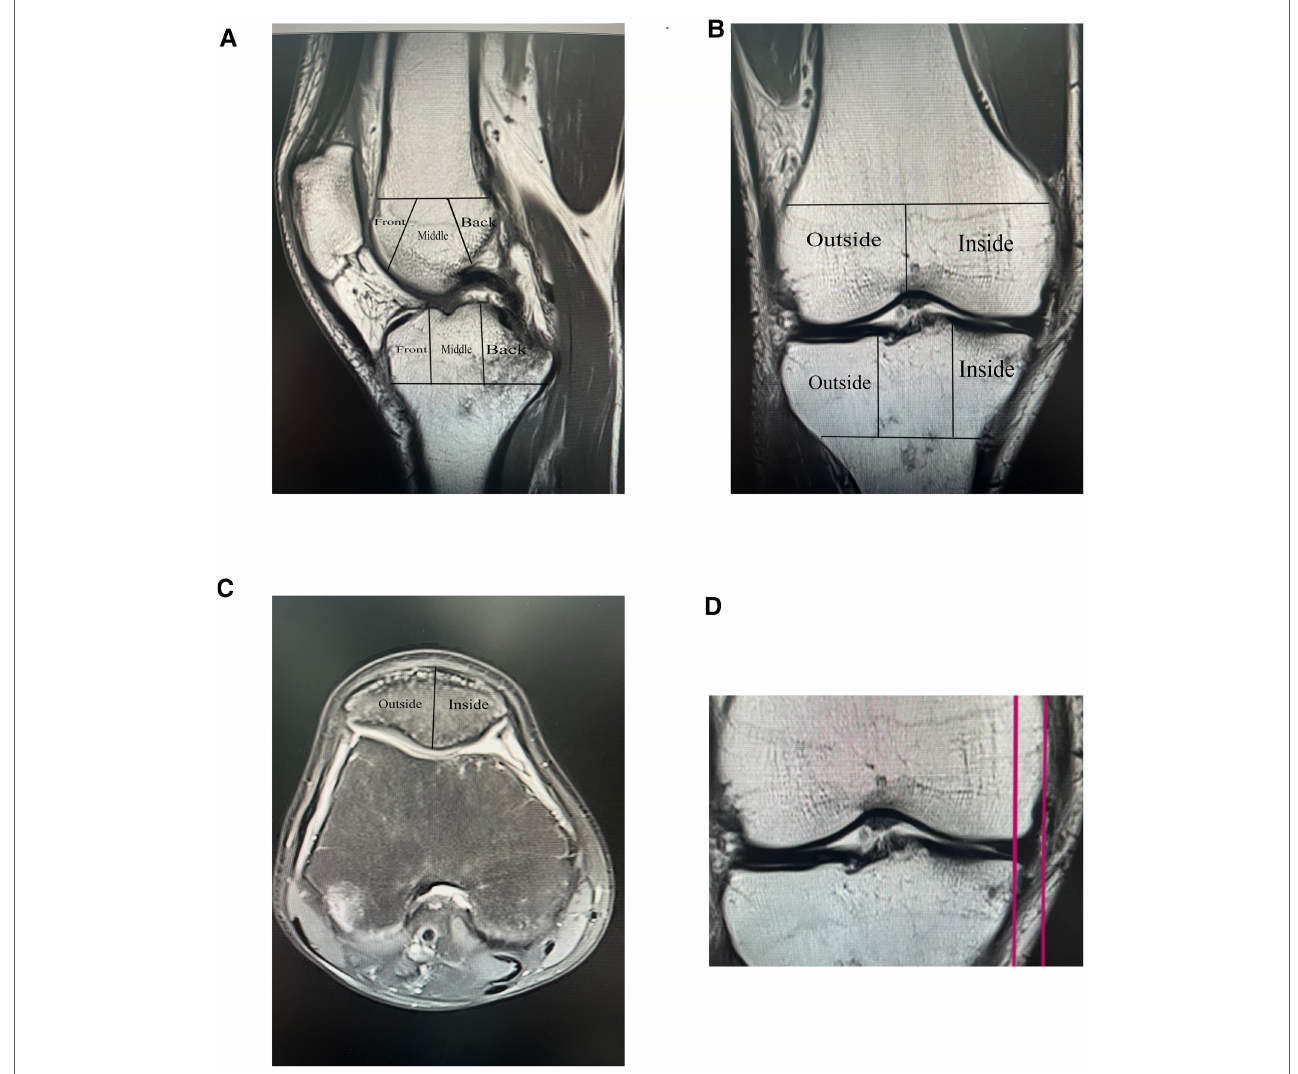
FIGURE 1 Imaging assessment, WORMS score and meniscus displacement map, ( A , B , and C ) Demonstrate the method of delineating regions for The Whole-Organ Magnetic Resonance Imaging Score (WORMS). ( D ) Shows an MRI coronal T1 image with an example of meniscus displacement, which in this illustration measures 6.1